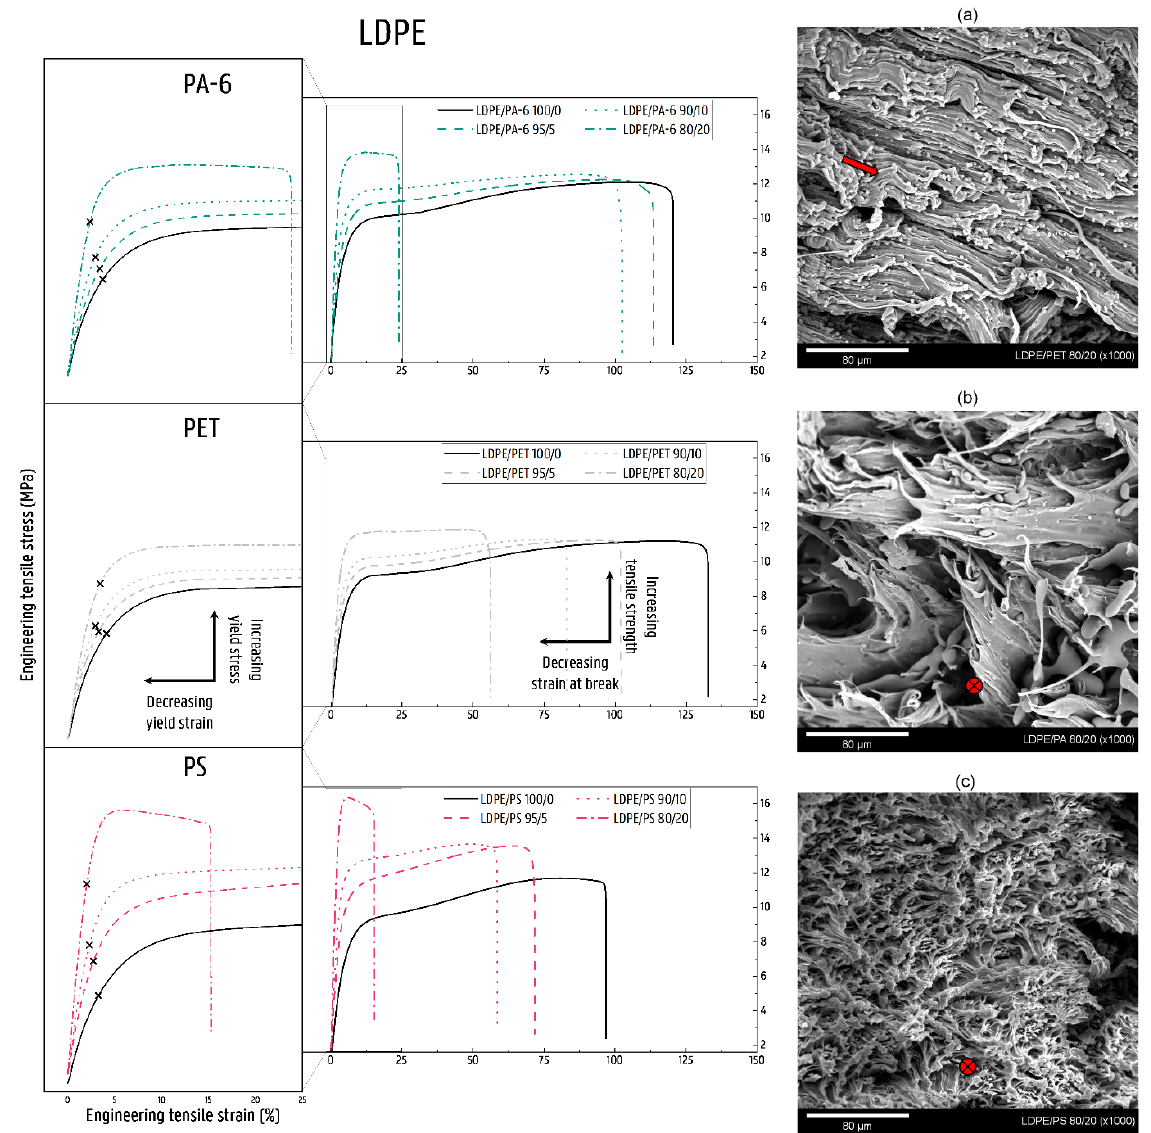
Figure 9. Stress–strain curves of the NPO-contaminated LDPE matrices (0, 5, 10, and 20 wt% PA-6, PET, or PS). The scanning electron microscopy (SEM) images show the area of rupture of the tensile- tested (deformed) binary blend specimens: ( a ) LDPE/PET 80/20, ( b ) LDPE/PA 80/20, ( c ) LDPE/PS 80/20. The red arrow indicates the polymer flow.